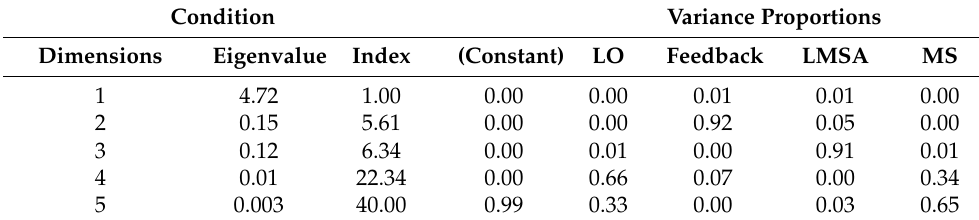
Table A2. Teaching methodology applied in the intervention groups.